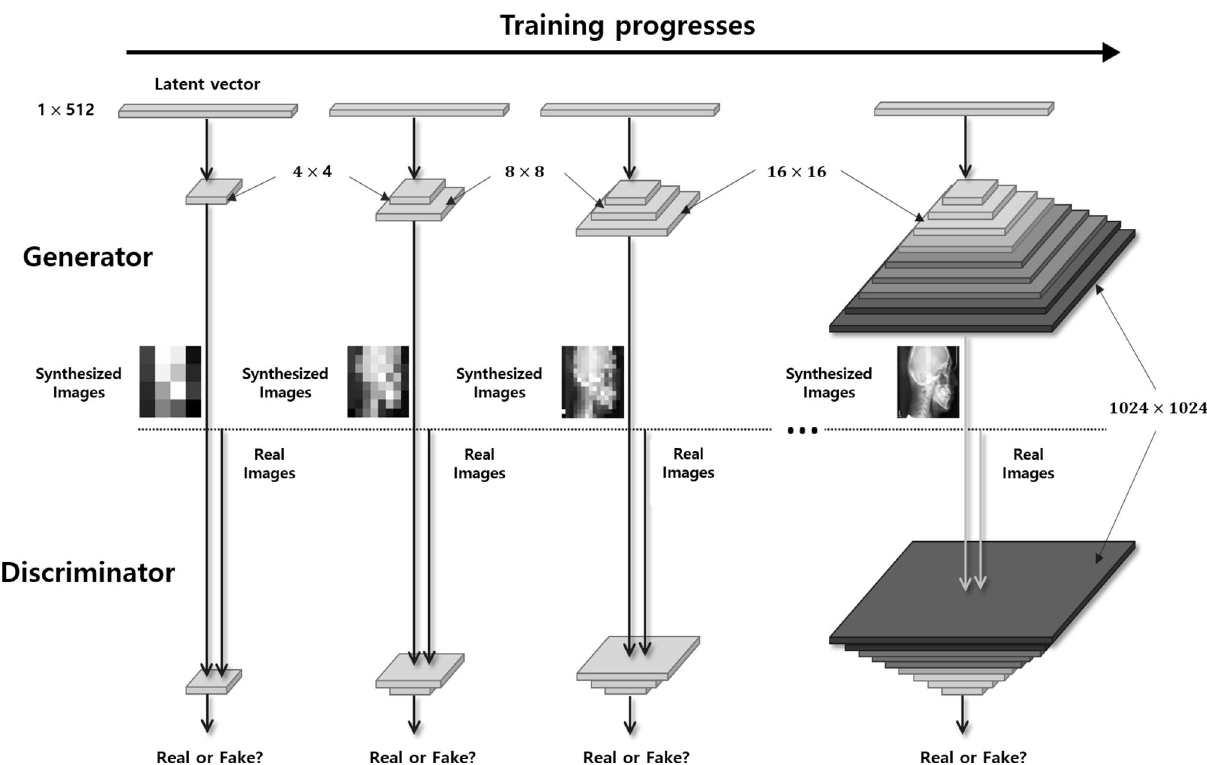
Figure 1. Conceptual architecture of PGGAN for training. PGGAN synthesizes images from a low resolution (4 × 4 pixels) to a high resolution (1024 × 1024 pixels) by adding layers to the